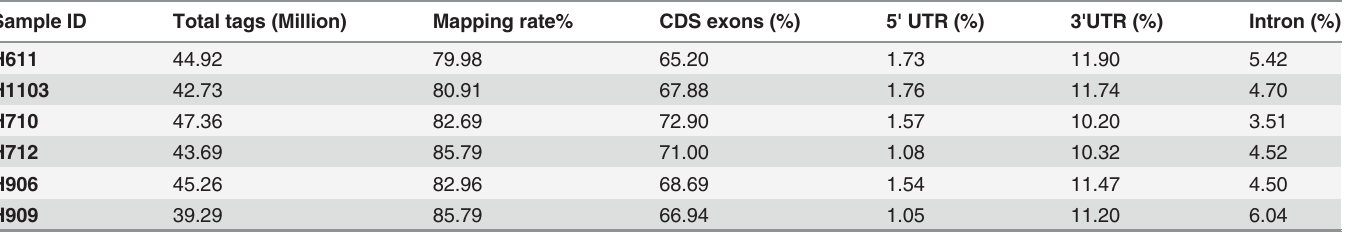
BH: Songliao Black pigs with higher backfat of live group BL:Songliao Black pigs with lower backfat of live group H710, H712 and H906, H909 are two pair full-sibs pigs. H710, H906,H611 and H712, H909, H1103 are the BH and BL groups